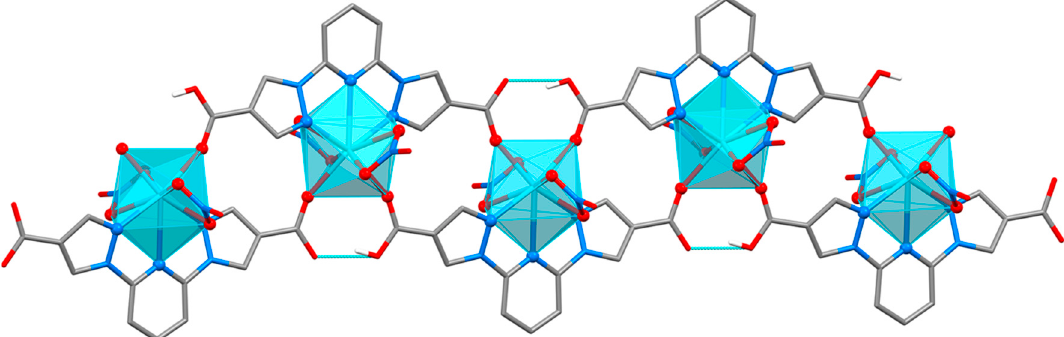
/ YbL 4 , with hydrogen bonds shown as dotted lines in 4 )(NO 3 ) 2 ] n in Tb